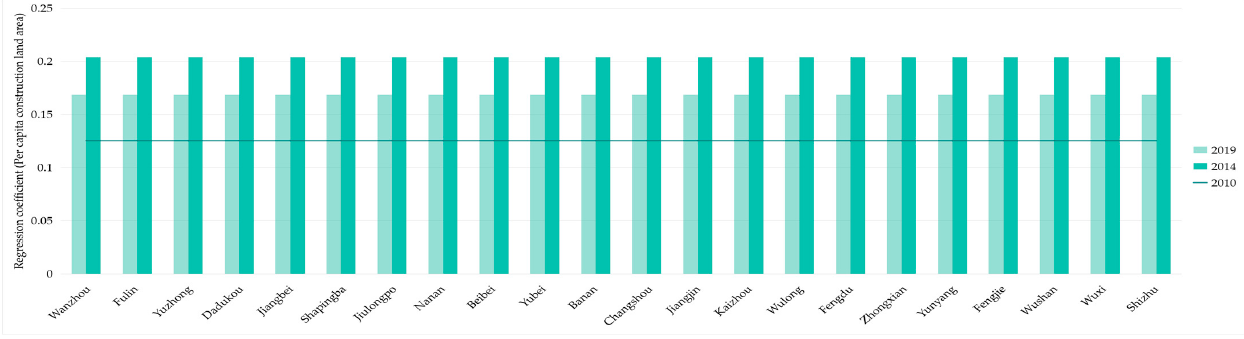
Figure 17. Changes of regression coefficient of L-UDI in the Three Gorges Reservoir Area (Chongqing section). Sources: Calculation results of the GWR model from the land-use dimension.